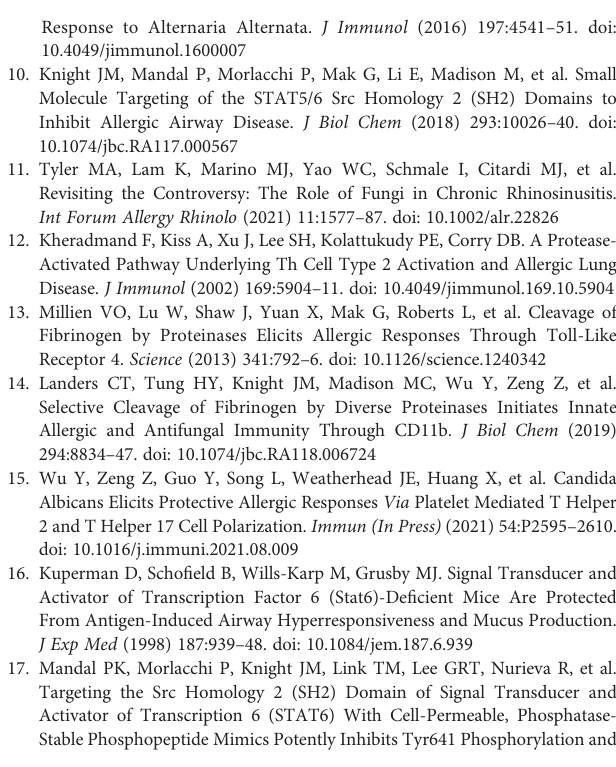
Supplementary Figure 1 | Intranasal fungal challenge promotes eosinophilic lower airway in fl ammation. (A) Mice were i.n. challenged with 4 × 10 5 A. niger (AN) or PBS every other day for 2 weeks and assessed for changes in airway resistance (RRS). (B) H&Eand (C) PASstaining oflungtissuefrom indicated challengegroups. Scale bars in the low and high magni fi cation were 100 m m and 10 m m respectively. Results represent mean ± s.e.m. from two independent experiments; p < 0.001, n = 5 by two-way repeated measures ANOVA. Supplementary Figure 2 | Sorted sinus in fl ammatory cells. Mice were challenged with 4 x 10 5 A . niger conidia for 2 months and sinus in fl ammatory cells were sorted. Supplementary Table 1 | Table lists published murine models of CRS, showing duration, route, allergen/adjuvant formulation, and pathology observed. Supplementary Table 2 | Table lists differentially expressed genes. Gene Ensembl ID, symbol, fold change, signi fi cance ( p adj < 0.05), full name and simplemine descriptions are presented in their corresponding